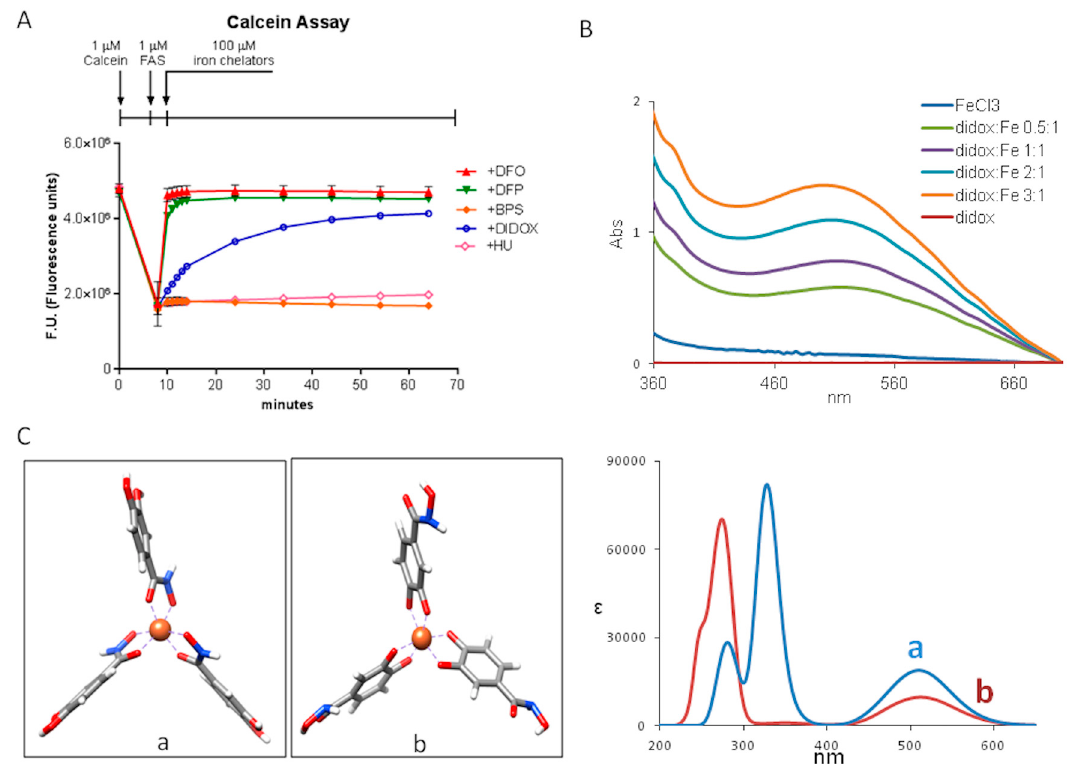
Figure 5. Didox retains the capacity to dequench the fluorescence of calcein forming a complex with iron (III). ( A ) The fluorescence of 1 µM calcein was determined, to set the basal level of the fluorescence at the beginning of the assay. Iron (II), as 1 µM FAS (ferrous ammonium sulfate), was added and allowed to equilibrate and form calcein-iron complexes for 8 min. Subsequently, 100 µM iron (III) chelators (such as DFO, red lines; DFP, green line), 100 µM iron (II) chelator (BPS, orange line), 100 µM didox (blue line) or 100 µM HU (pink line) were added. The fluorescence was measured after 1, 2, 3, 4, 5, 15, 25, 35, 45, 55 and 65 min after the addition of the compounds. ( B ) UV-vis spectra for complexes formed by base titration at constant concentration FeCl3 (300 µM) with increasing concentrations (0–900 µM) of didox in 25 mM Tris-HCl pH 7.2 buffer. ( C ) Left: Didox complexed with iron in the hydroxamic type of chelate (a) and catechol type of chelate (b). Right: Calculated UV-vis spectra of didox-iron complex a and b.